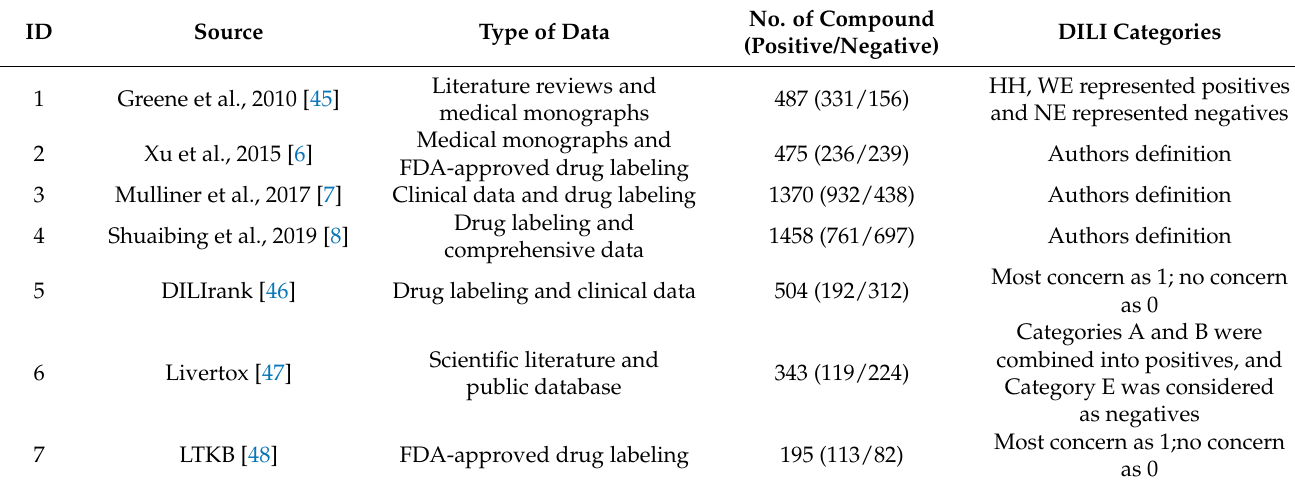
Table 1. Datasets of DILI and binarization rules of